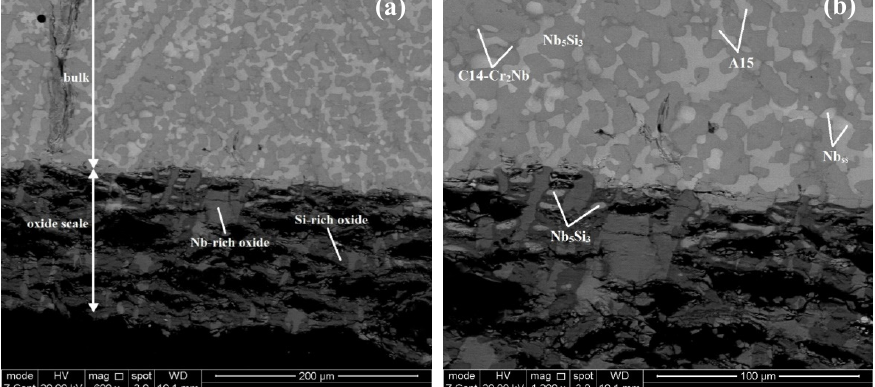
Figure 9. BSE images of the microstructure of a cross section of the oxidized alloy JZ3 at 800 °C: ( a ) low and ( b ) higher magnification images showing details of oxide scale and of the microstructure of the substrate below the scale.